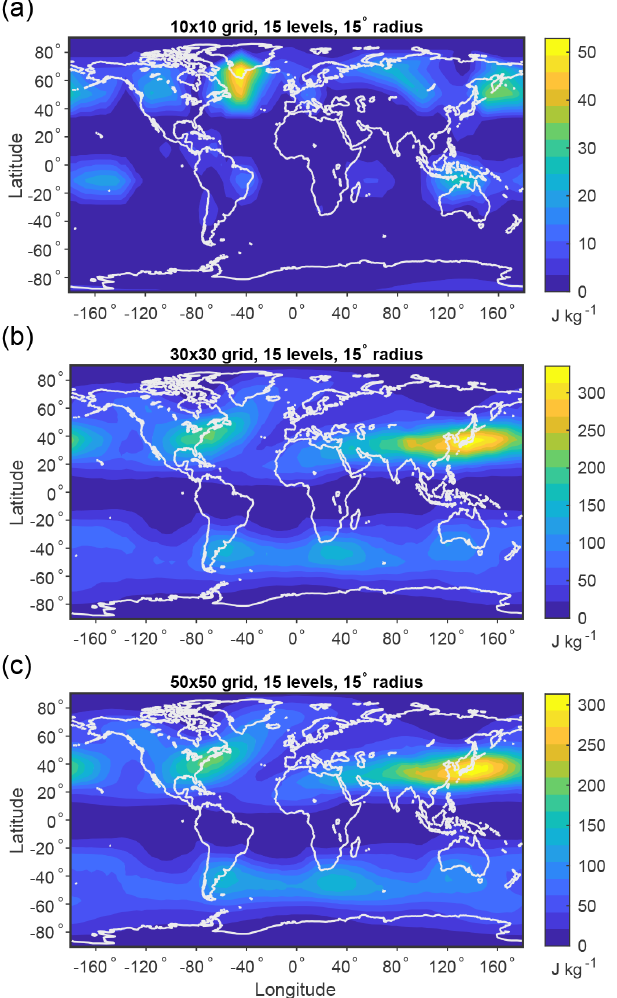
Figure B2. Maximum potential ascent in local MAPE based on the DJF climatological mean over 1979–2018 for grids of varying hor- izontal resolution: (a) 200 surface grid cells (a 10 × 10 grid in each hemisphere), (b) 1800 surface grid cells (a 30 × 30 grid in each hemisphere), and (c) 5000 surface grid cells (a 50 × 50 grid in each hemisphere). All results shown in this figure use 15 pressure levels and subdomains of geodesic radius of 15 ◦